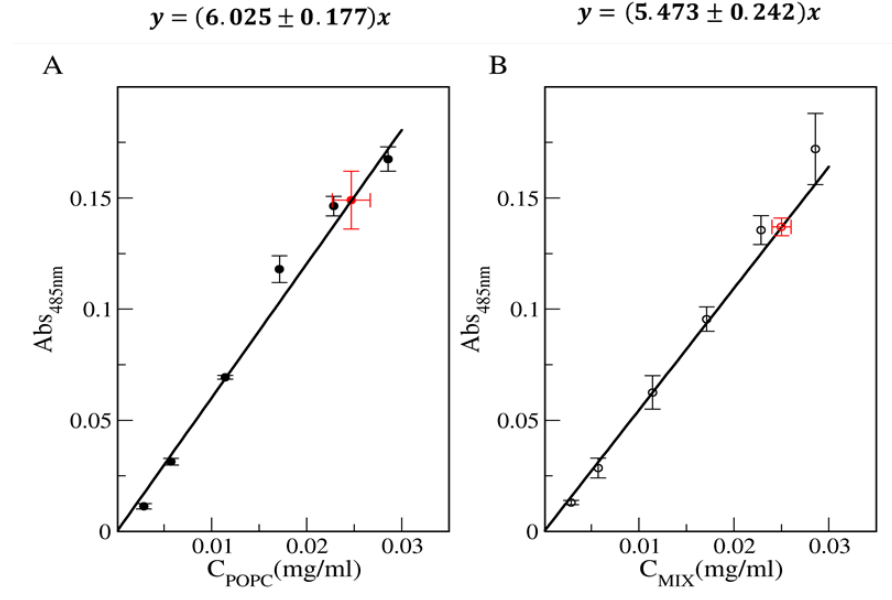
Figure 2. Calibration curves for ( A ) POPC_LIPO and ( B ) MIX_LIPO matrix. The errors’ weighted fitting functions are reported. The red point corresponds to the averaged value ± SE, obtained by a triplicate measurement, respectively for the evaluations of the POPC_LIPO_50 and MIX_LIPO_50 sample concentrations (reported as representative samples), by assuming the calibration curve of the Stewart